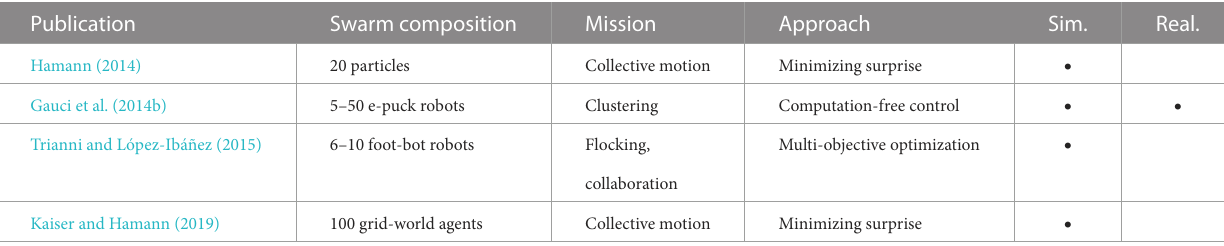
TABLE4 Overviewofselectedotherevolution-basedresearchinswarmrobotics.